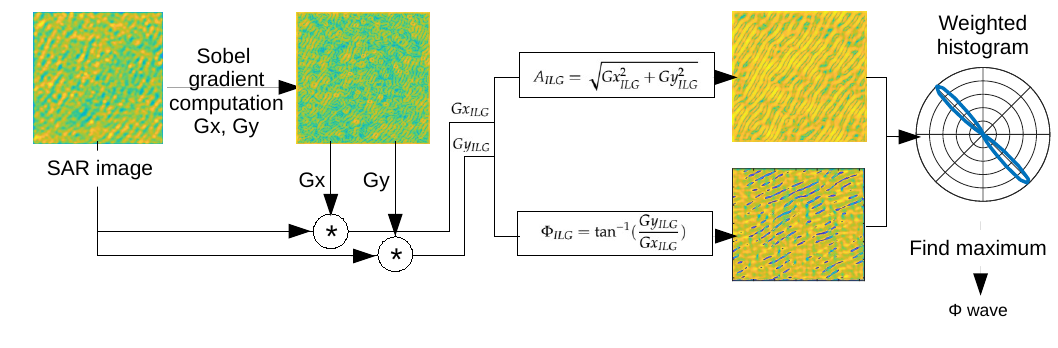
Figure 6. Summary of the gradient based